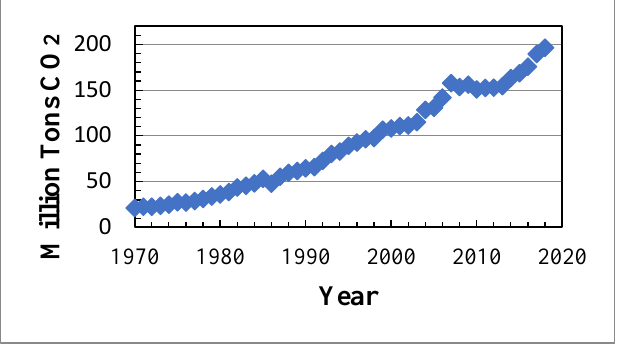
Fig. 1. GHG emission of Pakistan, reprinted with